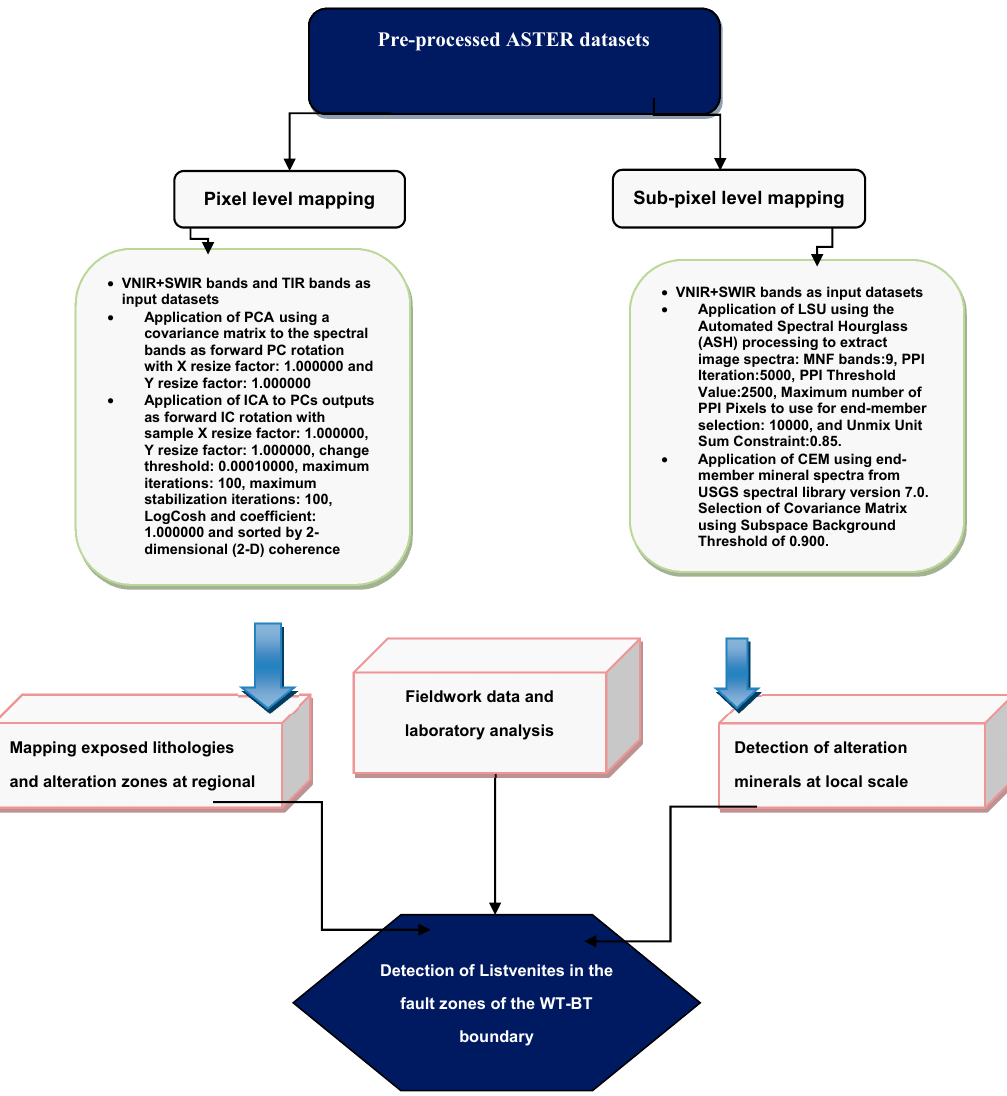
Figure 4. An overview of the methodological flowchart used in this study. Characterizations of the techniques can be found in ENVI Tutorials. Research Systems, Inc., Boulder, CO [81].